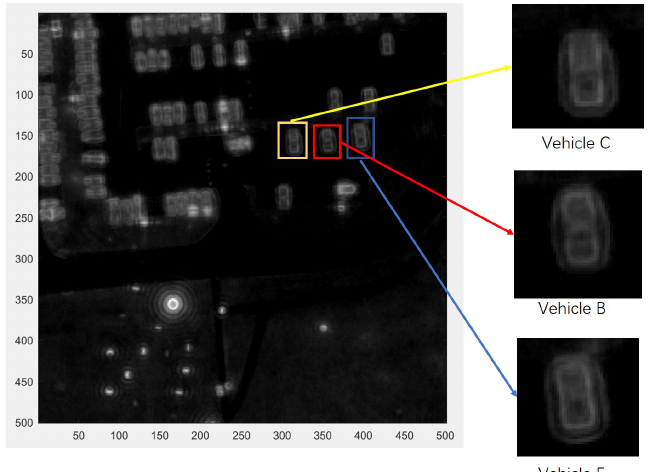
Figure 5. Full scene of entire 360 ◦ aperture after RPCA.